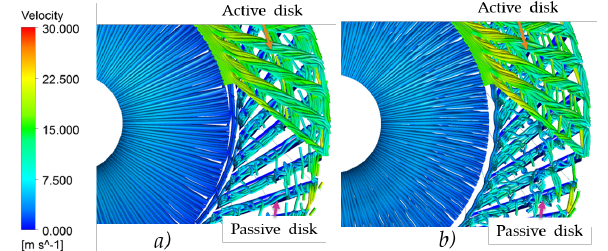
Figure 7: The views of the absolute and relative streamlines coloured by velocity: a) k- ϵ turbulence model, b) k- ϵ RNG turbulence